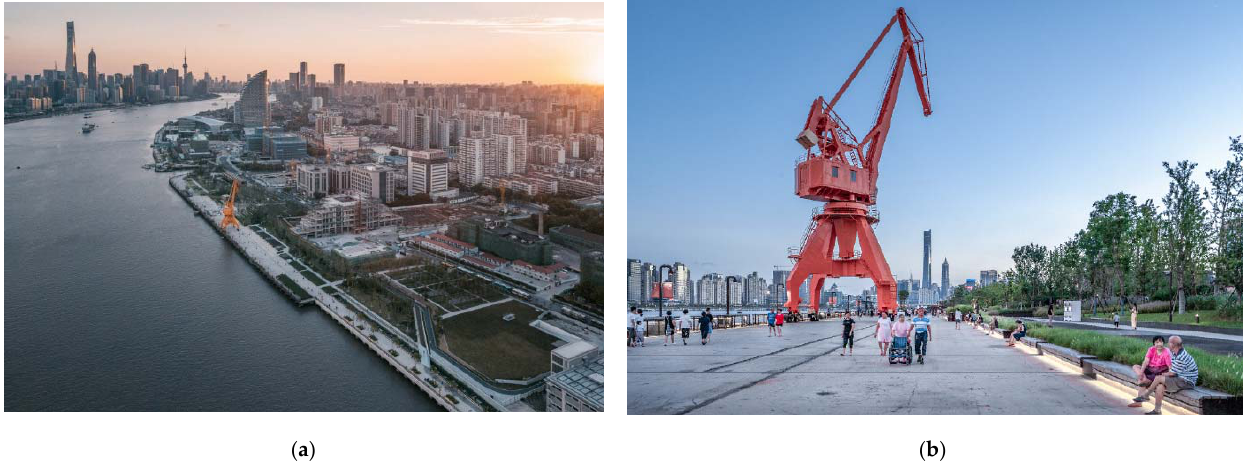
Figure 12. Connected shoreline in the downtown area of the Huangpu River ( a ); the dock crane was completely retained as a new visual focus ( b ) Source ( a , b ): DA Landscape, Photographer: Jin Xiaohui.